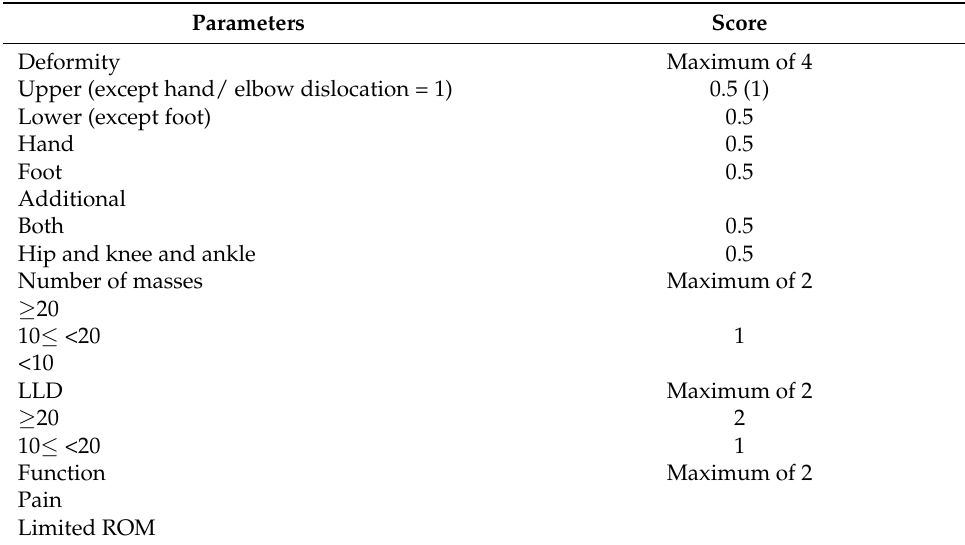
Table 1. Scoring system ‘De-Nu-L-F’ used in this